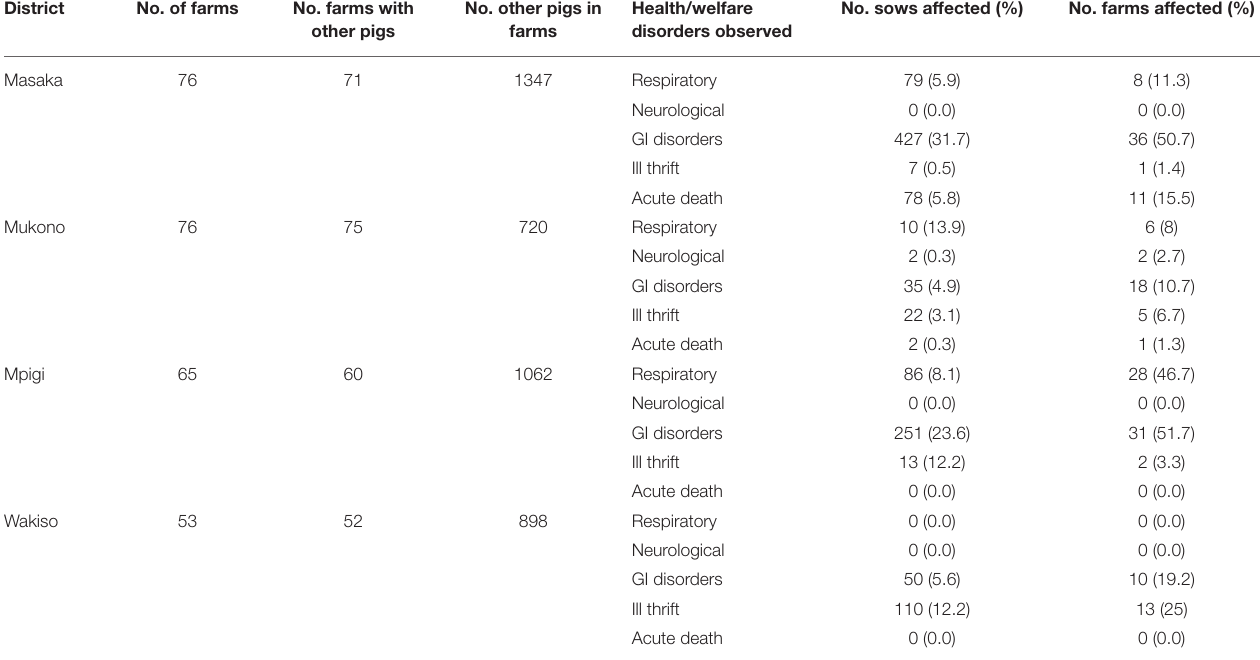
TABLE 7 | Health/welfare challenges of other pigs. District No. of farms